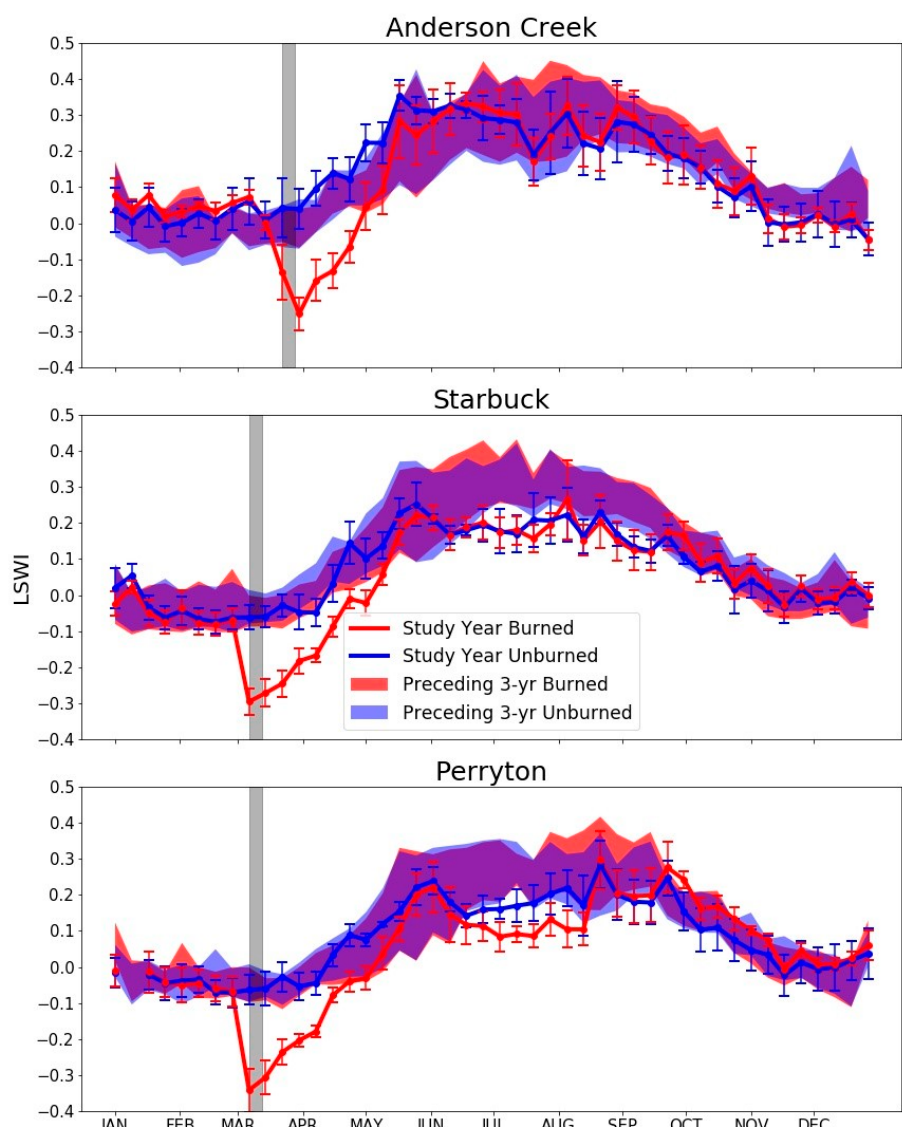
Figure 4. Three year average Land Surface Water Index (LSWI) values for the unburned plots (blue shaded) and burned plots (red shaded) of the Anderson Creek (top), Starbuck (middle), and Perryton (bottom) wildfires. Fire year LSWI averages for the unburned (blue) and burned (red) plots are shown as solid lines with error bars of one standard deviation. Time of fire is marked by grey shaded columns.